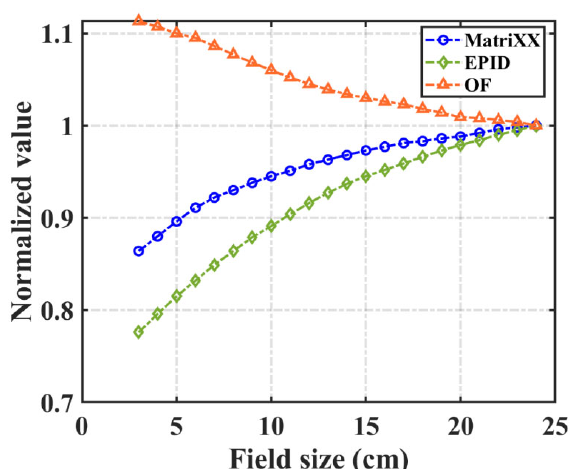
Figure 7. The EPID pixel value, MatriXX dose value and field output factor (OF) at the central axis of different fields. All values were normalized to the field of 24 × 24 cm 2 .